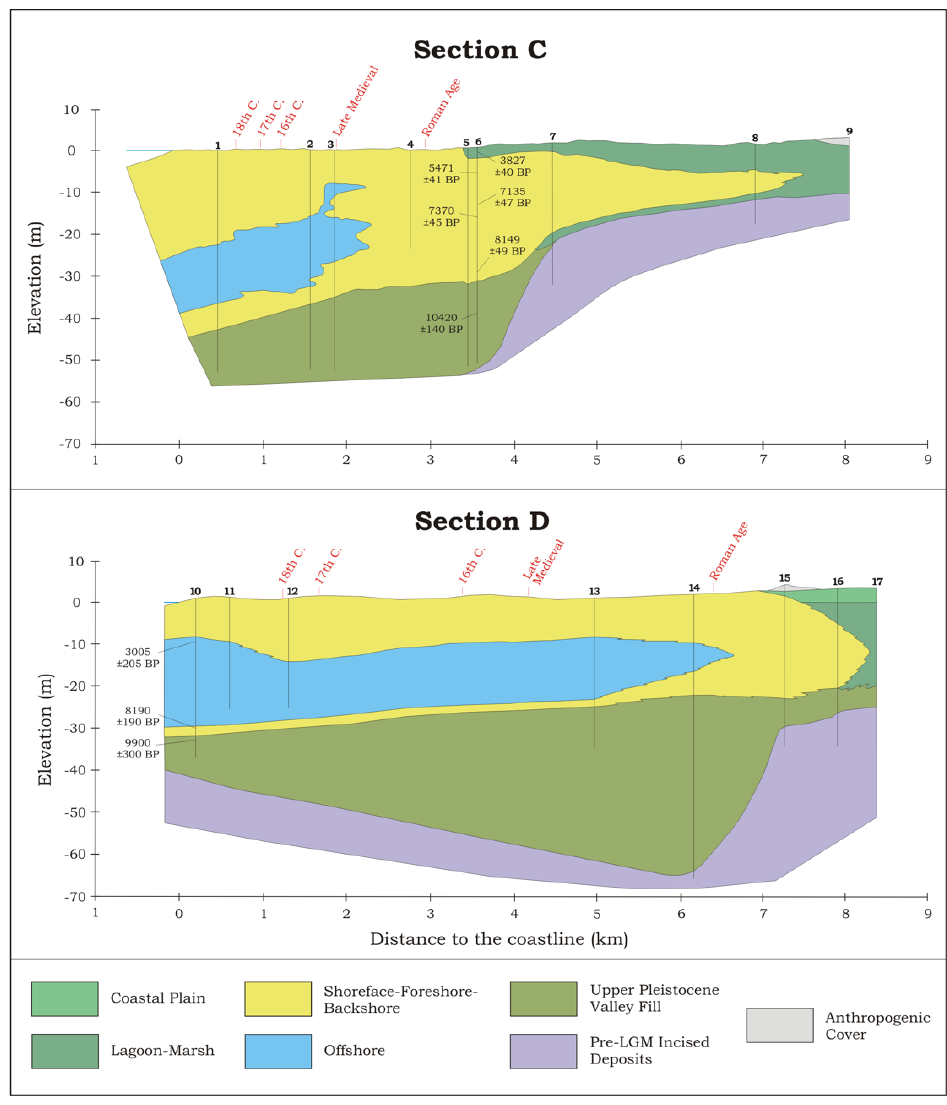
Figure 5. Stratigraphic sections C and D. The current position of the coastline is located at 0 m along the x-axis. The numbers in black correspond to the boreholes used to produce the sections. The vertical scale is exaggerated by a factor of 20. 1: SIRA 113; 2: DB ITALMACO; 3: SALOV; 4: CSN 151; 5: RECORD 47; 6: BERGAMIN; 7: SIRA 177; 8: SIRA 257; 9: RECORD 159; 10: M1; 11: RMS26; 12: C2806; 13: VIRGO 2; 14: BG; 15: DBS BASILICA; 16: C5976; 17: C5806.